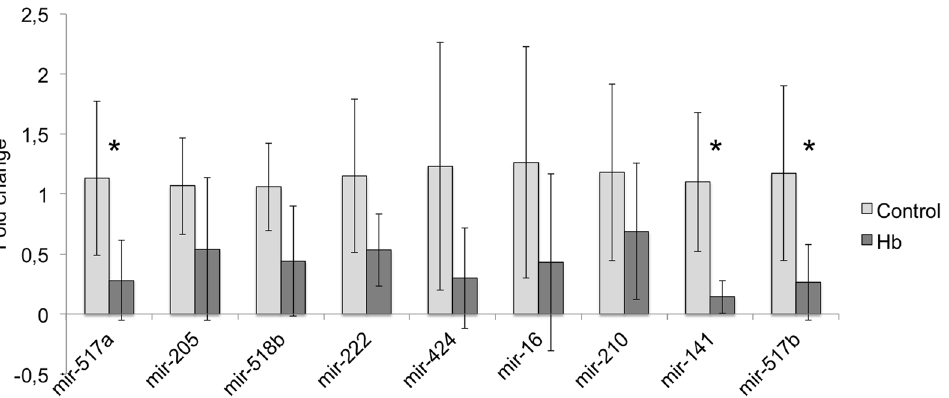
Figure 3. Bar charts showing miRNA fold change in STBMs from control and Hb perfusions. Nine selected miRNAs were analysed using quantitative PCR, as described in the Materials and methods section. The miRNA expression was normalized against Rnu6b and given as fold change. The fold change values were calculated by normalizing against control samples from control perfused placentas. Results are presented as mean 6 SD. Differences between the respective control and Hb perfusions were analysed using Mann-Whitney U -test. * p , 0.05. In the 10K STBMs mir-517a, mir- 141 and mir -517b were significantly down regulated in Hb perfusions compared to controls. No significant differences were detected in the 150K STBMs (data not